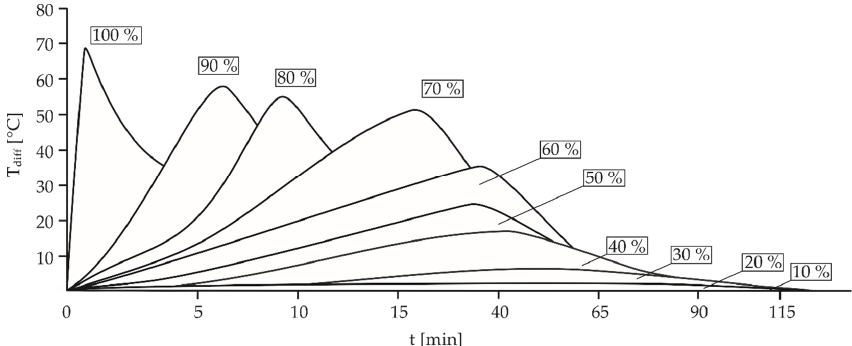
Figure 6. Heat release over time for the various pyrite-calcite mixtures (90:10 to 10:90 pyrite:calcite) during IR thermography testing. Decreasing pyrite concentrations result in lower maximum temperatures and a longer reaction time.